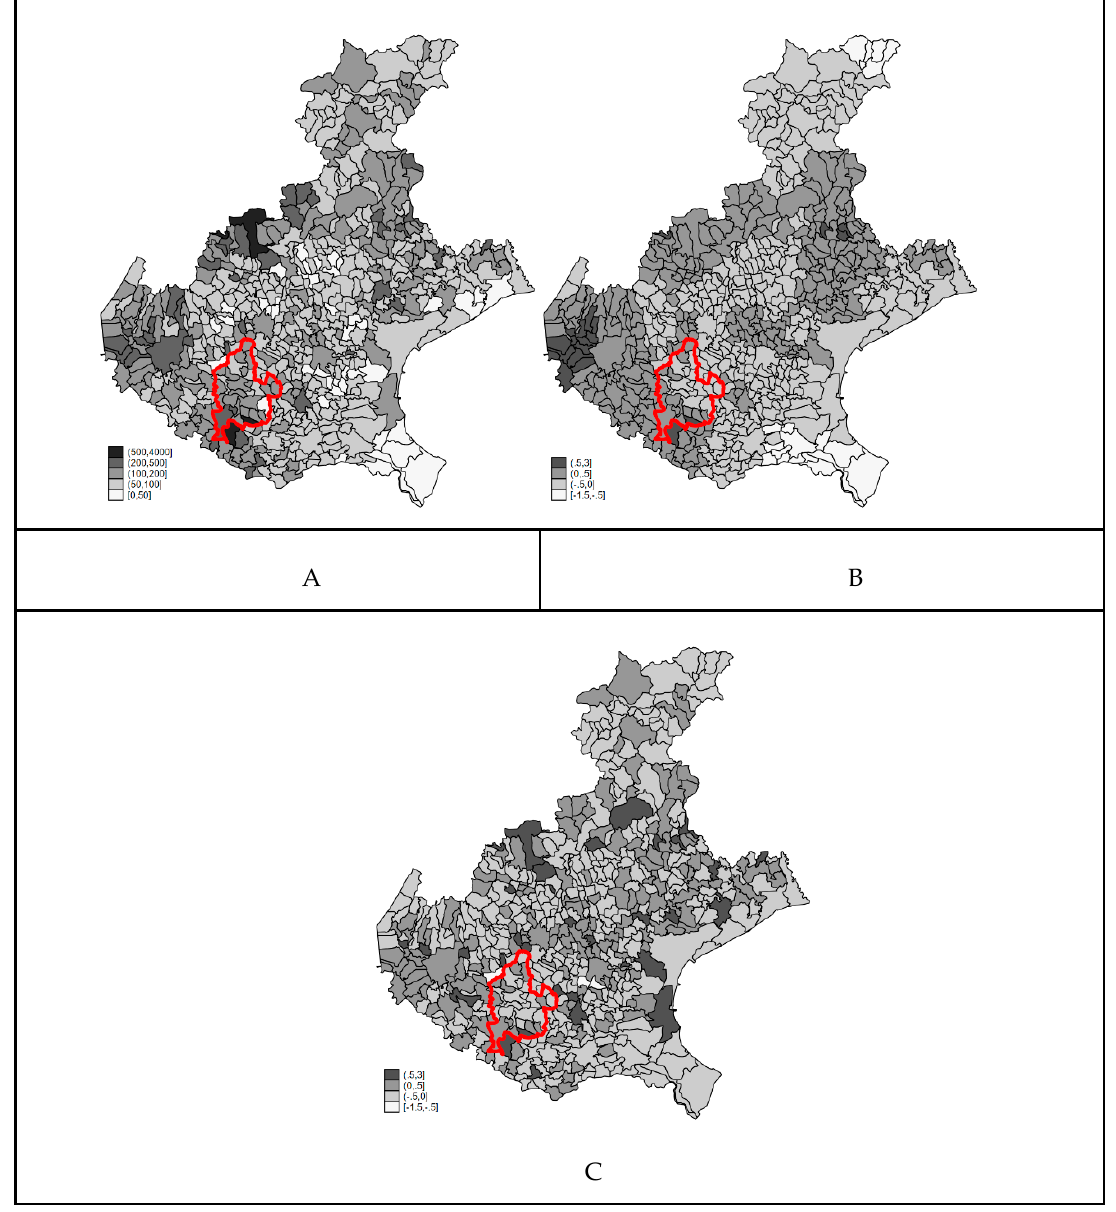
Figure 3. Smoothed mortality rate for COVID-19 (×100,000) ( A ), clustering ( B ), heterogeneity ( C ) random terms from the negative binomial regression models, Veneto Region. Borders of the Red Zone are highlighted in red.